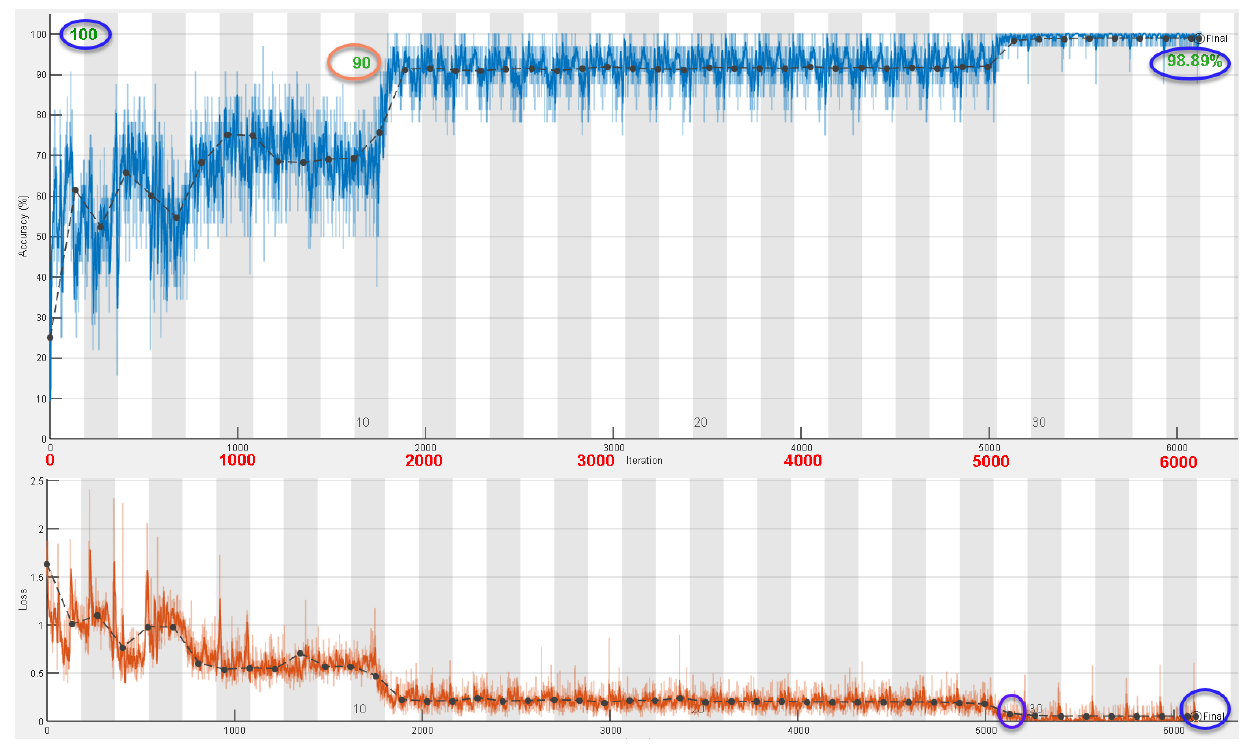
Figure 12. LSTM network training and validation plot.